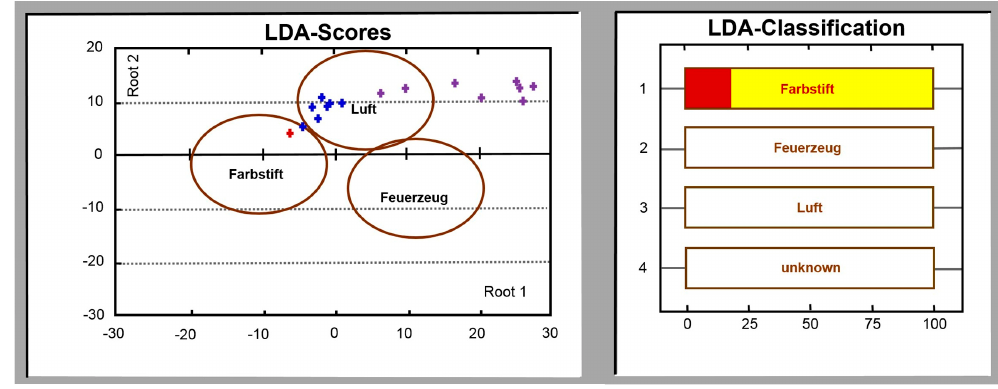
Figure 8. The PC screened image of the e-nose software under the long-term operation. Several last measurement points are displayed with the blue crosses while the last point is marked by the red color. Blue crosses and the classification table at the right side show a transition of e-nose state from the “ambient air” (“Luft”) to the “odor induced by felt-pen” (“Farbstift”). The violet crosses indicate e-nose signals which are classified as “others” (“unknown”). The red bar fraction shown in the right plot corresponds linearly to the position of red cross: it disappears when the cross is on the ellipse’s boundary and takes the complete bar, if the cross is in the center. The class “lighter” is marked as “Feuerzeug”.